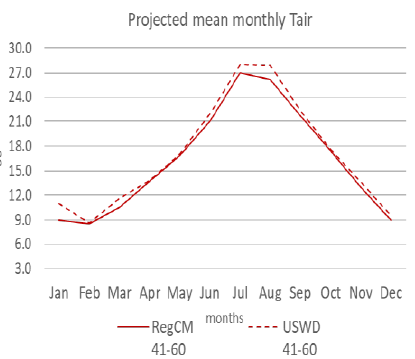
Figure 10. Estimated mean monthly Tair for the future weather datasets RegCM_41-60 and USWD_41-60.